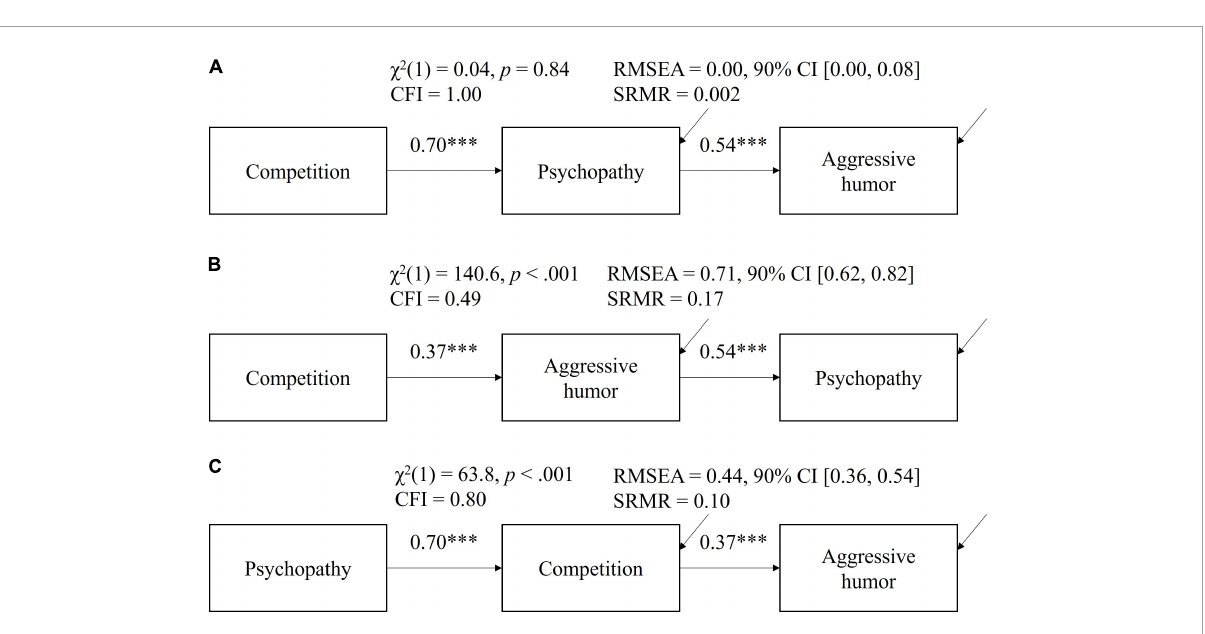
FIGURE3 Comparing the fit of three competing indirect-effect models with model (A) as our proposed model and models (B,C) as alternative models. Arrow lines pointing toward mediator- and outcome variables represent residual terms. Larger p -values of the chi-square test, larger CFI values, smaller RMSEA values, and smaller SRMR values indicate better model fit. *** p < 0.001.